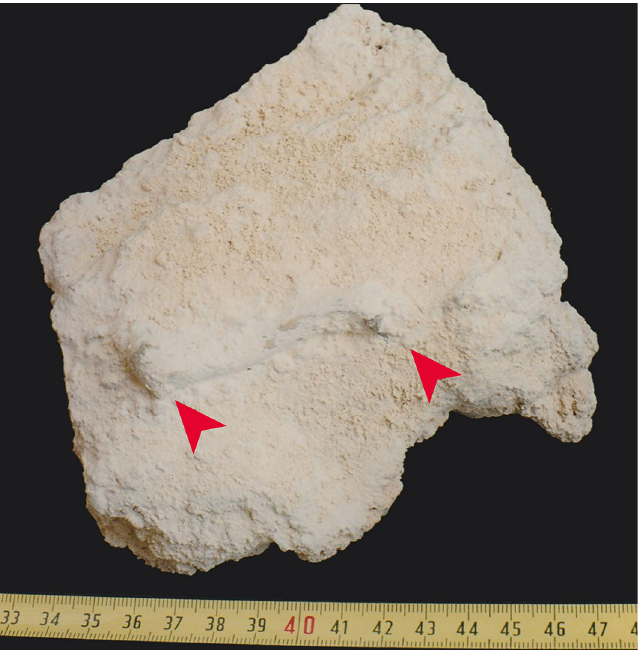
Figure 4. Holotype of Geochelone atlantica López-Jurado, Mateo and García-Márquez, 1998 (DBULPGC 17) in original matrix before preparation. Arrowheads point to femoral epiphyses (photo: L. F.